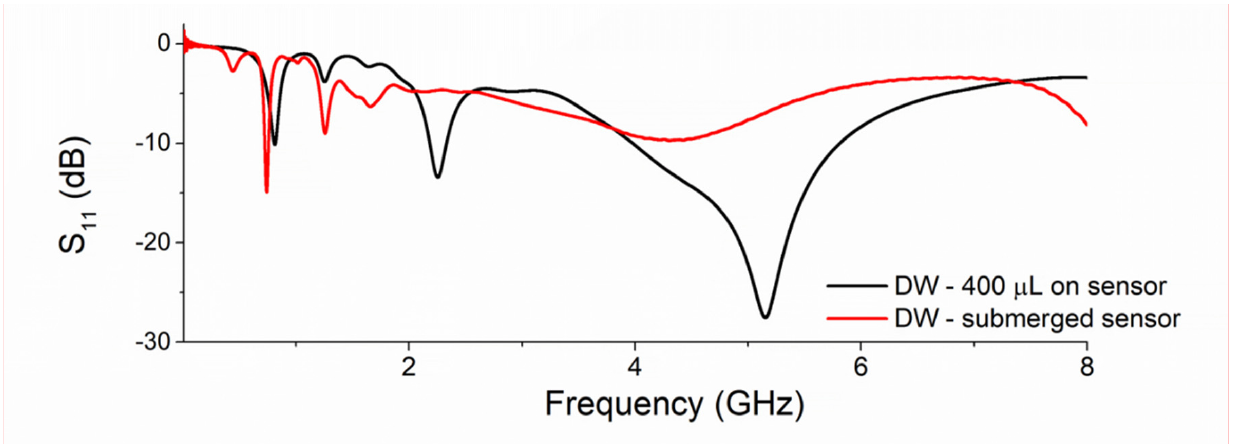
Figure 8. Comparison of the microwave signal between placing 400 µ L of water sample onto sensor versus dipping the sensor in a water sample.